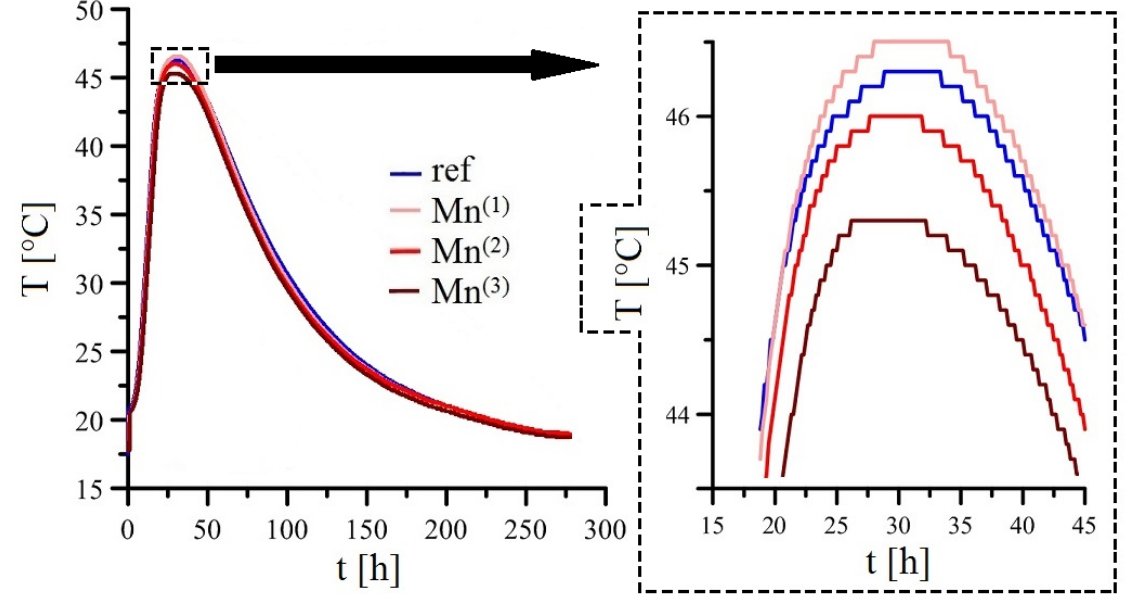
Figure 11. Temperatures of hydrating concrete samples without addition or with addition of KMnO 4 (overview; curves—mean values).